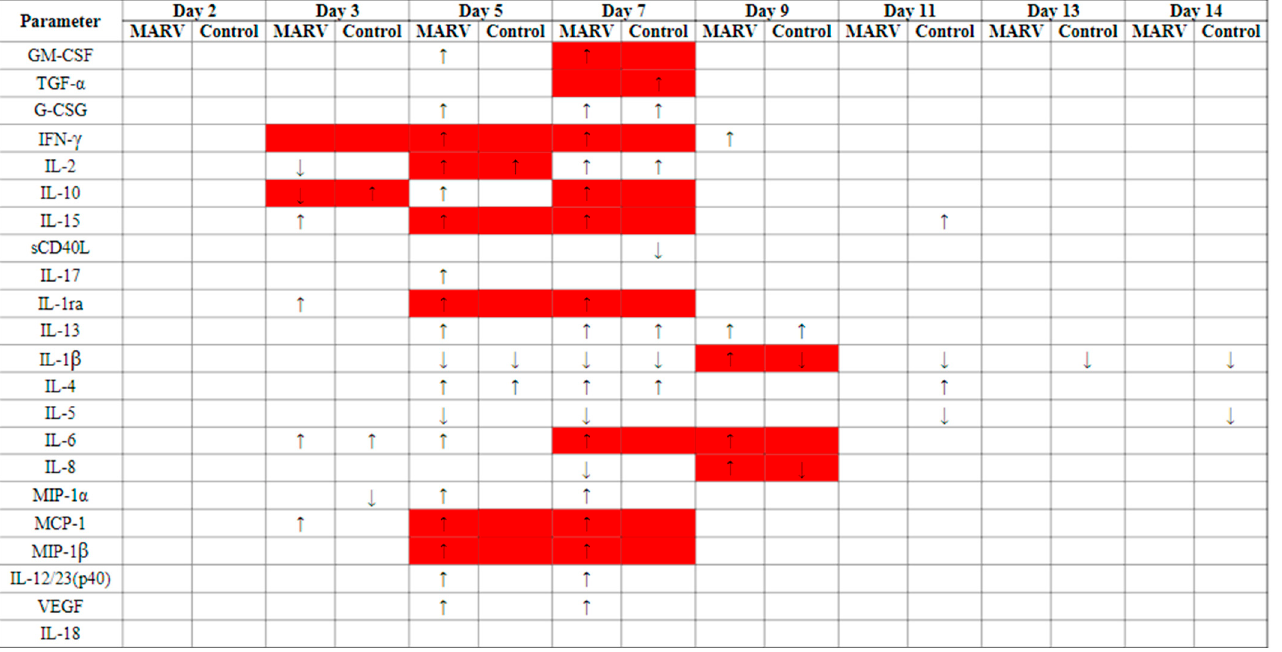
Figure 7. Cytokine and chemokine changes from baseline throughout study for MARV ‐ exposed versus mock ‐ exposed group. Arrows ( ↑ , ↓ ) indicate that the mean on the study day was significantly greater (“ ↑ ”) or less (“ ↓ ”) than that at the baseline (Day 0) at the 0.05 level. Red shaded cells indicate that the change from baseline for the MARV ‐ exposed group was significantly different to that of the mock ‐ exposed control group at the 0.05 level. For days 11, 12, and 14, only samples from mock ‐ exposed animals were available.